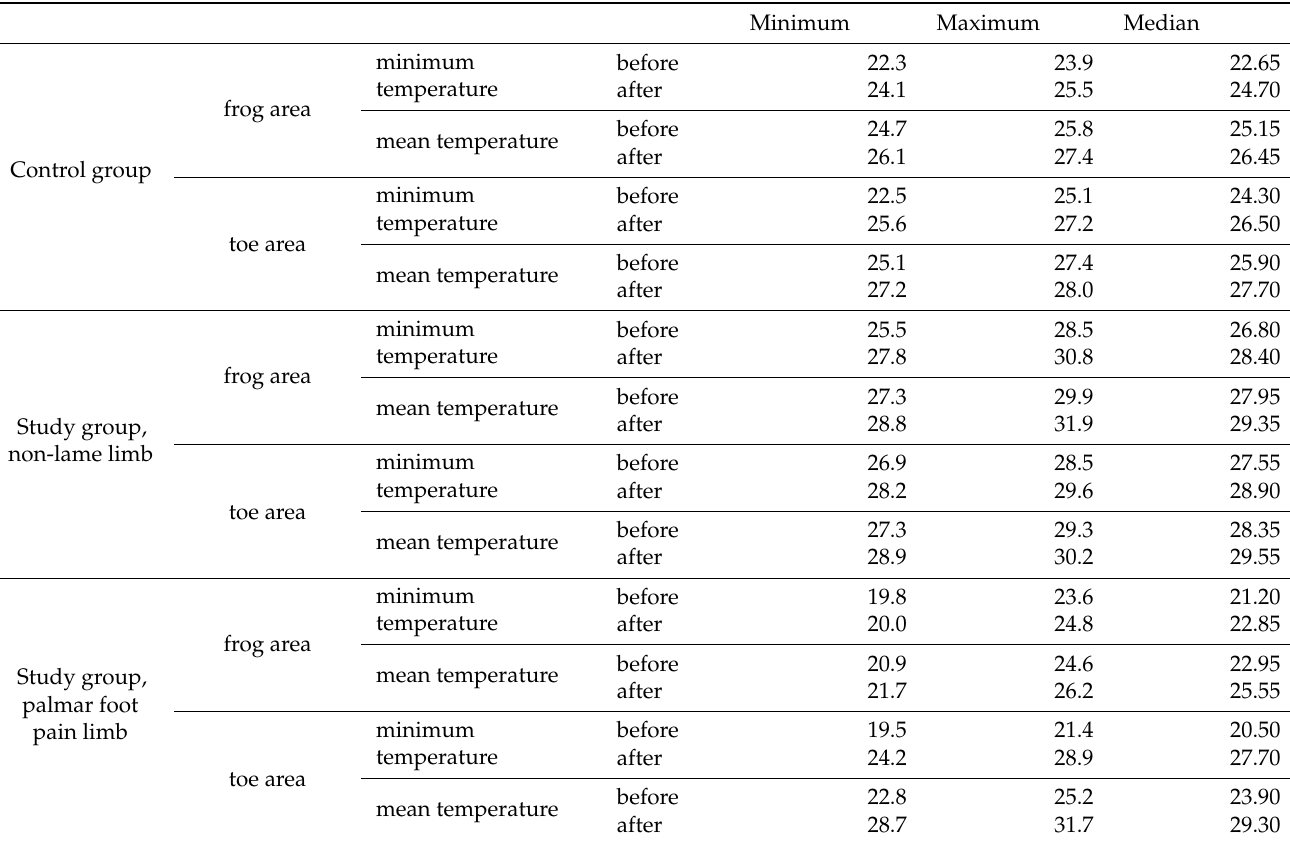
Figure 3. Study group, limbs with palmar foot pain: ( a ) sole surface before training—small surface of increased temperature in the frog area (blue arrows) and toe area (black arrows); reduced temperature along the hoof wall (white arrows); minimum temperature recorded in the area—blue triangle spot; maximum temperature recorded in the area—red triangle spot; ( b ) sole surface after training— increased temperature and wider surface of increased temperature in the toe area (black arrows); no obvious changes in local temperature in the frog area (blue arrows); increased temperature along the hoof wall (white arrows); minimum temperature recorded in the area—blue triangle spot; maximum temperature recorded in the area—red triangle spot. Table 1. Descriptive statistics for minimum, maximum, and mean temperature for each